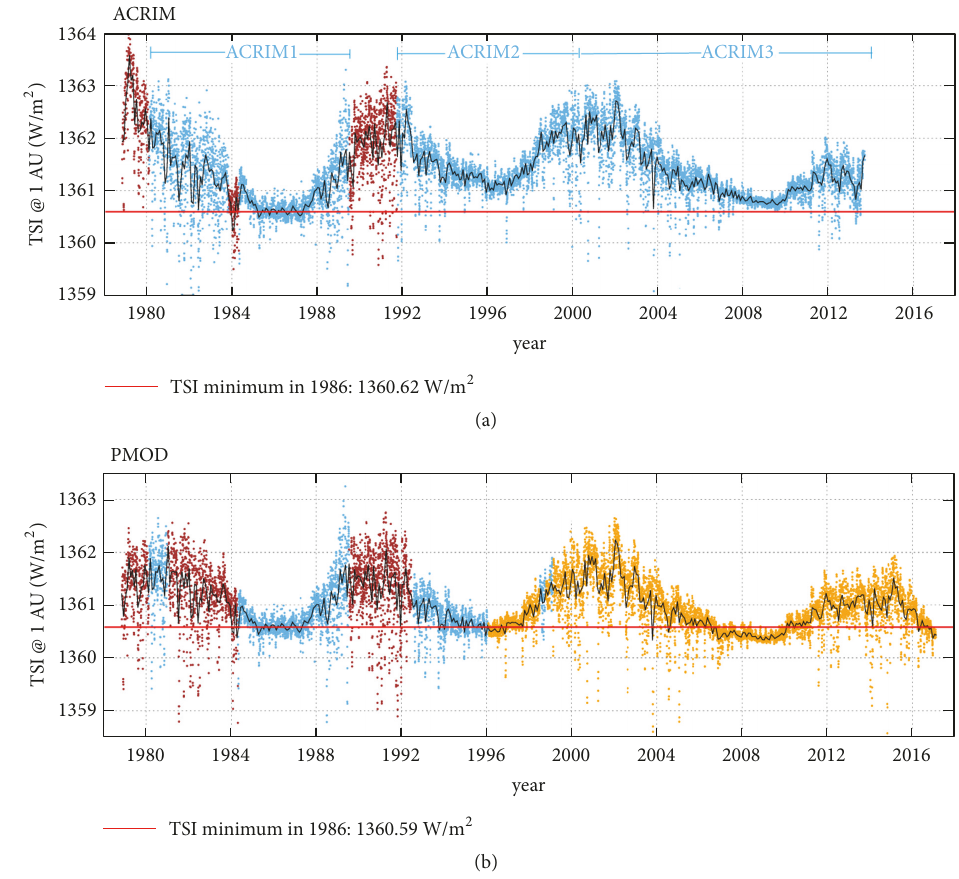
Figure 1: (a) ACRIM TSI composite. (b) PMOD (v. 1702) TSI composite [7, 14]. Components of each composite are ACRIM123 (blue), Nimbus7/ERB (brown), and VIRGO (orange).